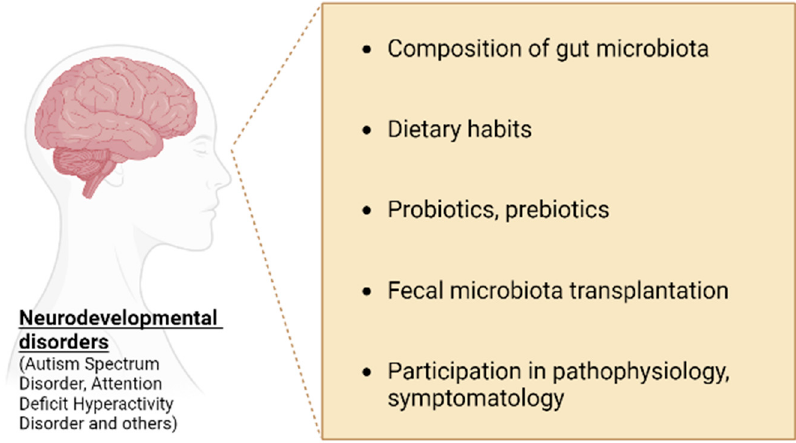
Figure 2. Interactions between gut microbiota and neurodevelopmental disorders.